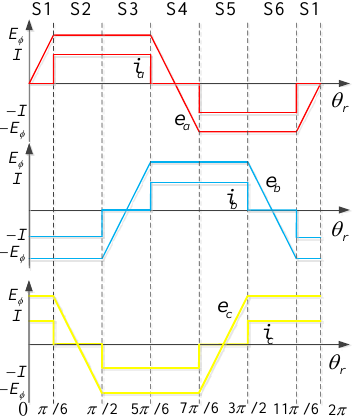
Figure 1. Ideal waveforms of back-EMF and phase current in square-wave current control (SWC).